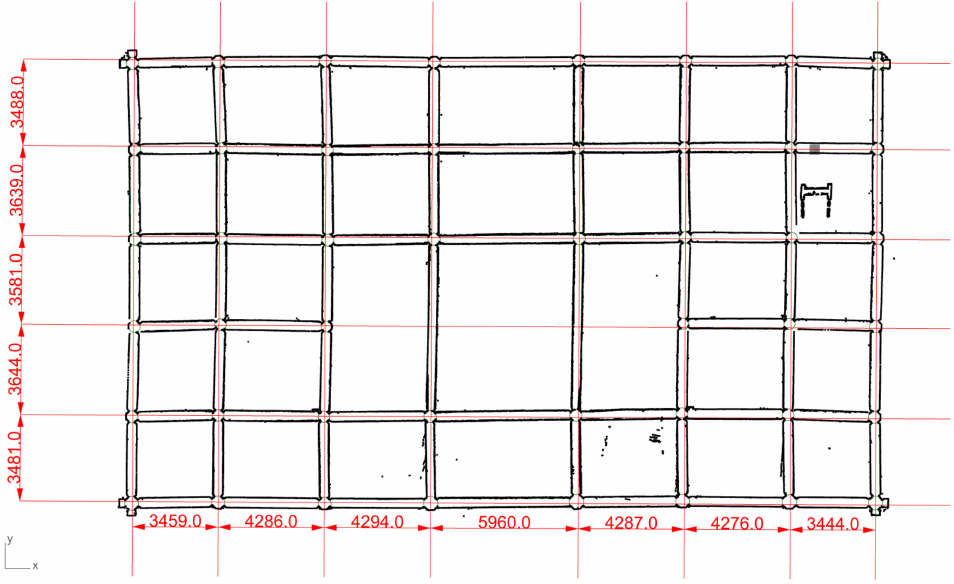
Figure 18. Axis rebuilt with the genetic algorithm in